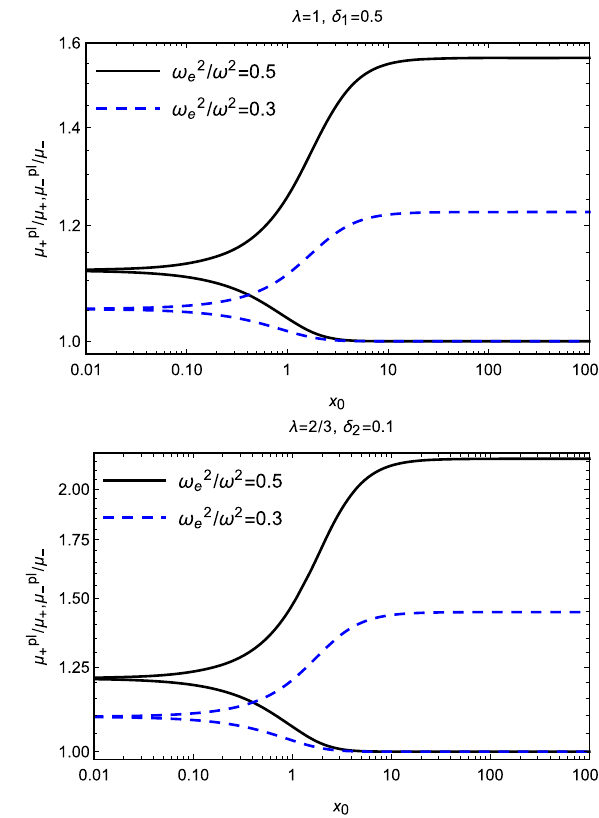
Fig. 20 Magnification for λ = 1 and λ = 2 / 3 in uniform